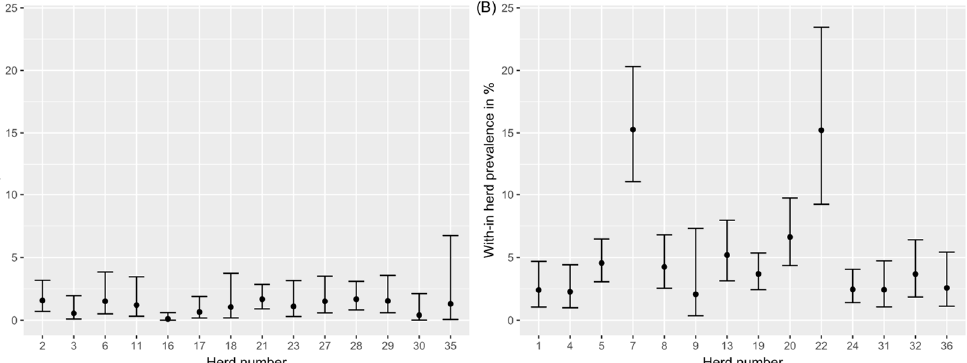
Figure 1. Estimated true within-herd prevalence of animals shedding Mycobacterium avium subsp. paratuberculosis (MAP) and its 95% confidence interval for each study herd. ( A ) Herds with at least one MAP-positive individual fecal sample and an estimated true prevalence of less than 2% (group 1). ( B ) Herds with at least one MAP-positive individual fecal sample and an estimated true prevalence of at least 2% (group 2).